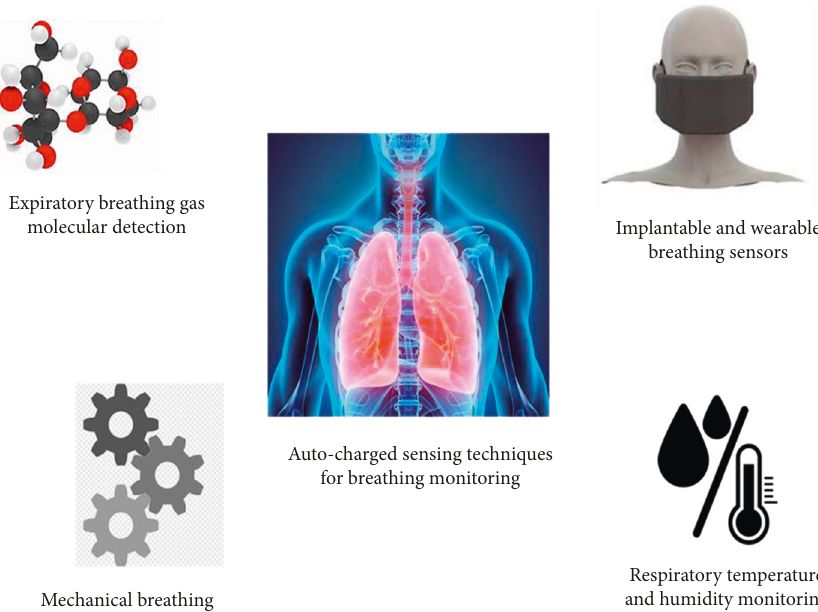
Figure 1: Auto-charged sensors application in respiration monitoring.